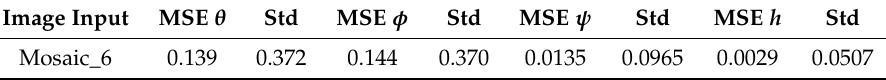
Table 5. MSE and its standard deviation (Std) for the prediction of the flight commands φ , θ , ψ , h using DeepPilot. A mosaic image composed of 6 frames was used as input. The network was trained with 5000 images and evaluated with 400 images.